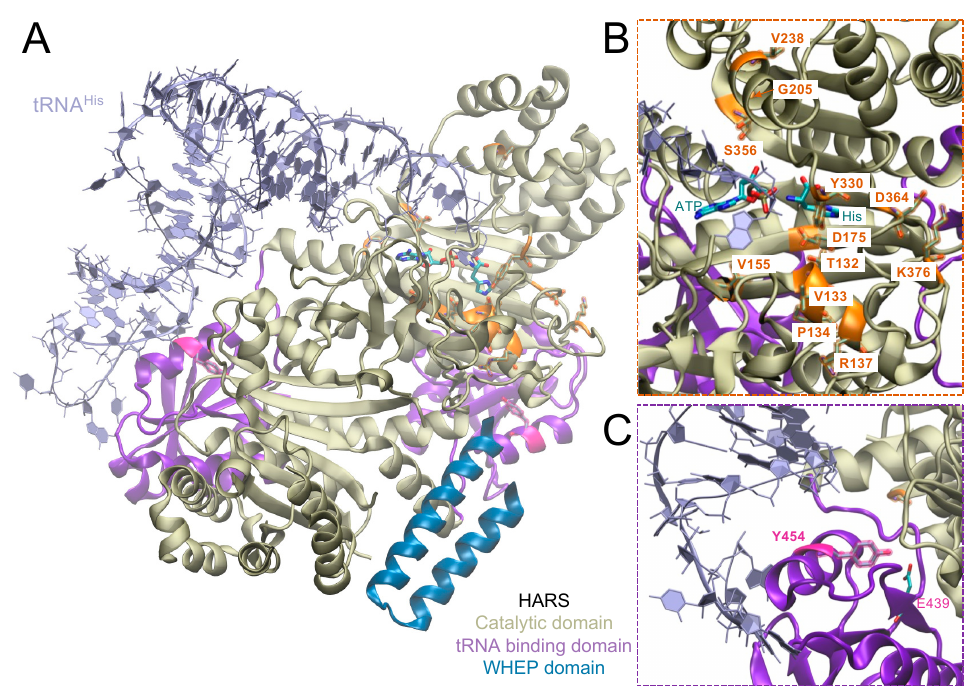
Figure 2. Localization of CMT and USH3B causing HARS mutations. ( A ) Crystal structure of human HARS with CMT and USH3B-causing mutations. The human HARS dimer is shown (pdb:6O76) [29] with the WHEP domain in blue, catalytic domain in tan, and RNA binding domain in purple. The structure was superimposed with the crystal structure from Thermus thermophilus (pdb:4RDX) [30], and the tRNA (lavender) is shown. Histidine and ATP are highlighted in the active site. Magnification of ( B ) the catalytic domain with CMT causing mutations depicted in orange, and ( C ) the RNA binding domain with the USH3B mutation Y454S in magenta. The amino acid E439 forms a salt bridge with Y454 that is disrupted in a Y454S mutation. The structure was illustrated using VMD [31].